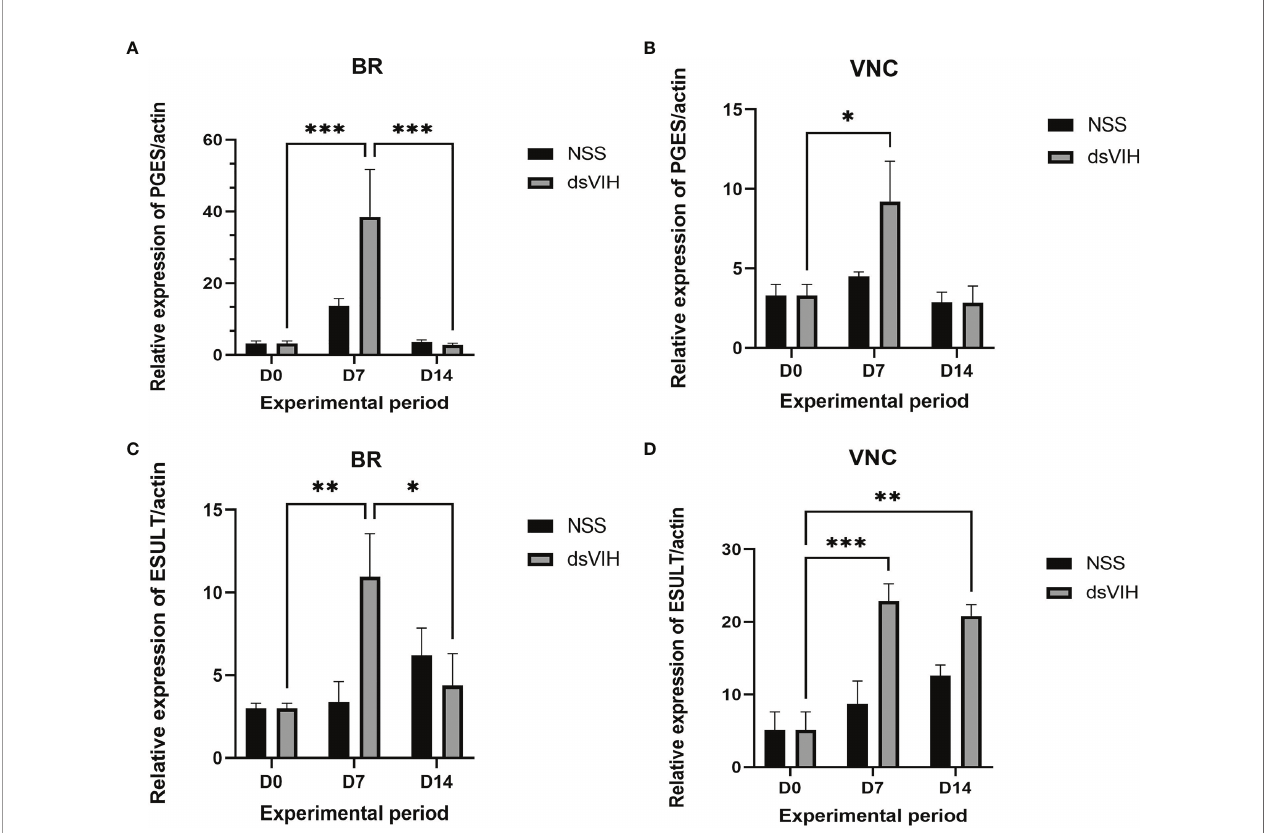
FIGURE 7 | Effect of dsRNA-VIH on the Scyol-PGES and Scyol-ESULT transcript abundances using quantitative RT-PCR. (A, B) The histograms showed the level of Scyol-PGES which signi fi cantly expressed higher in brain and VNC after dsRNA-VIH administration for 7 days. (C, D) The histograms showed the level of Scyol- ESULT which signi fi cantly expressed higher in brain and VNC after dsRNA-VIH administration for 7 and 14 days. BR, brain; VNC, ventral nerve cord. Bars represent the standard error of the mean (SEM). * p < 0.05, ** p < 0.005 and *** p <